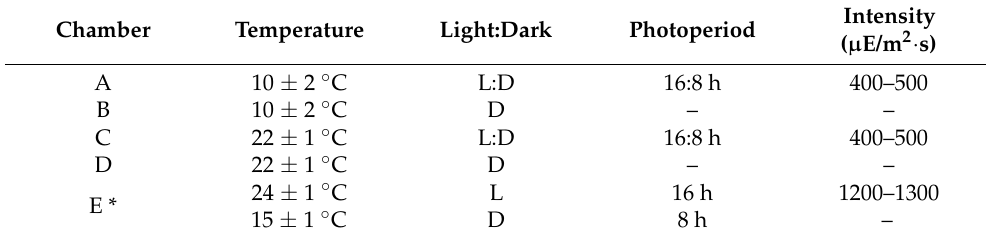
Table 1. Conditions of the different chambers to the